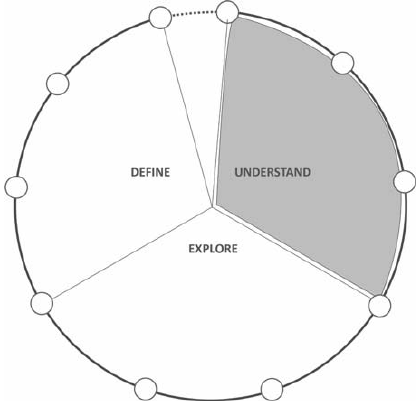
Figure 4. PSS design process phase: Understand.